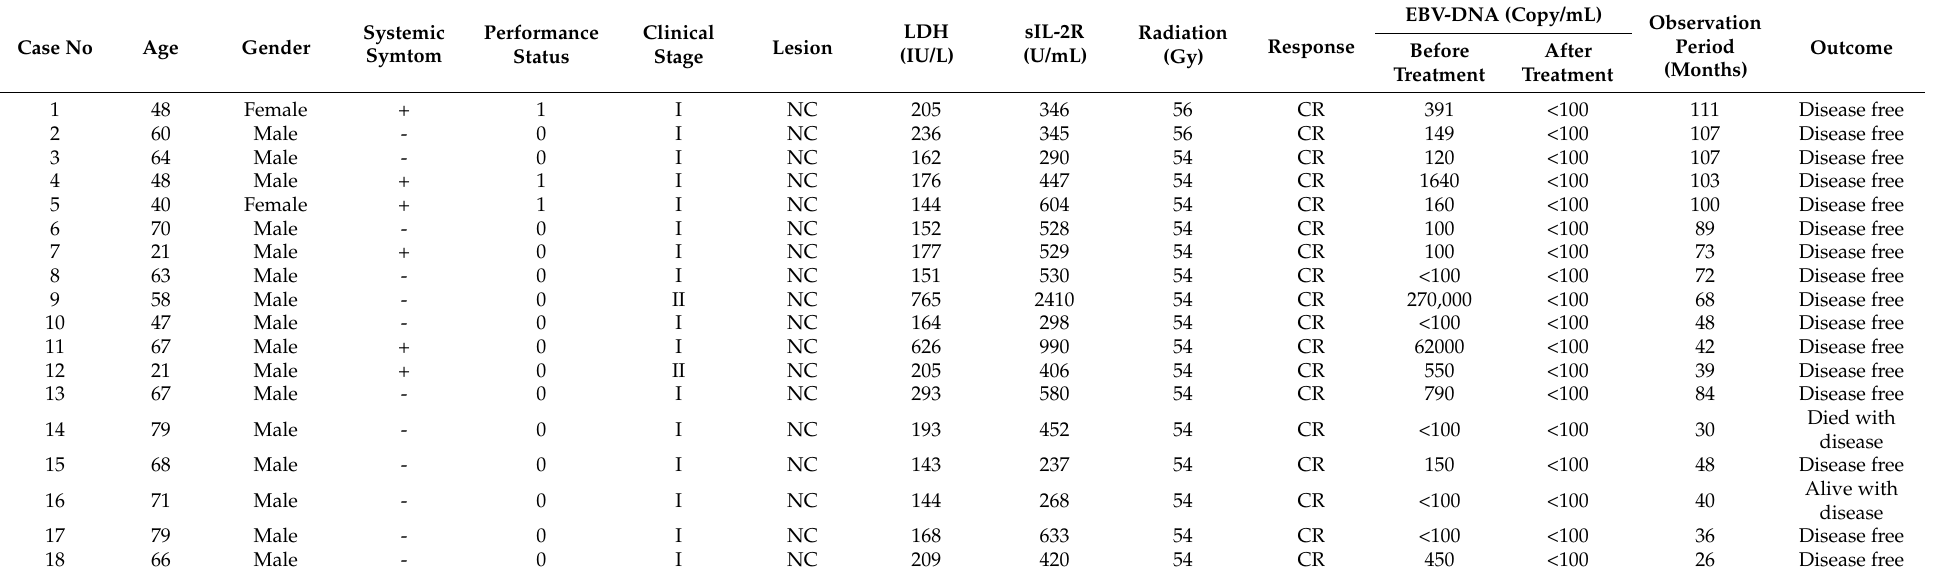
Table 2. Overview of the 18 patients with extranodal NK/T-cell lymphoma, nasal type treated with arterial infusion MPVIC-P